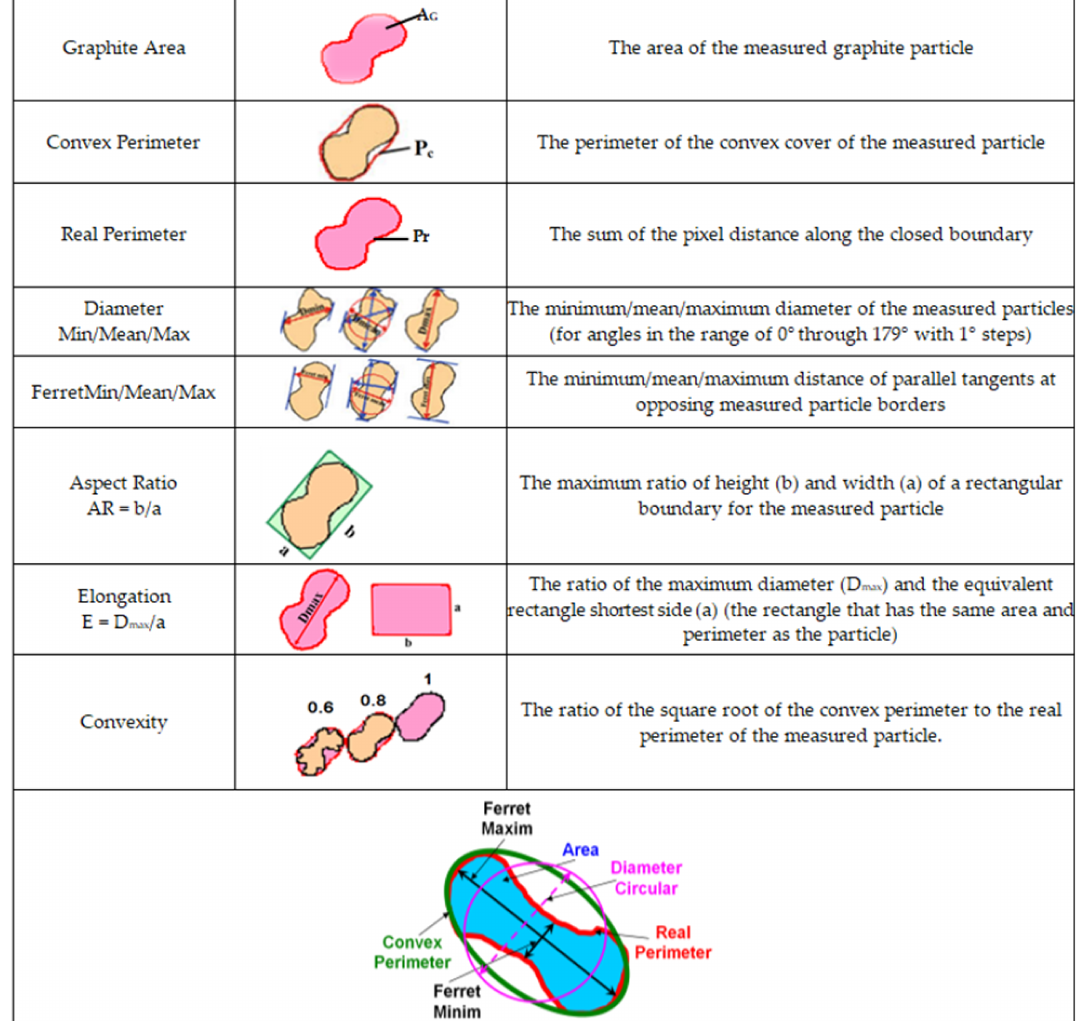
Figure 3. Graphite particle parameters that were evaluated using image analysis.